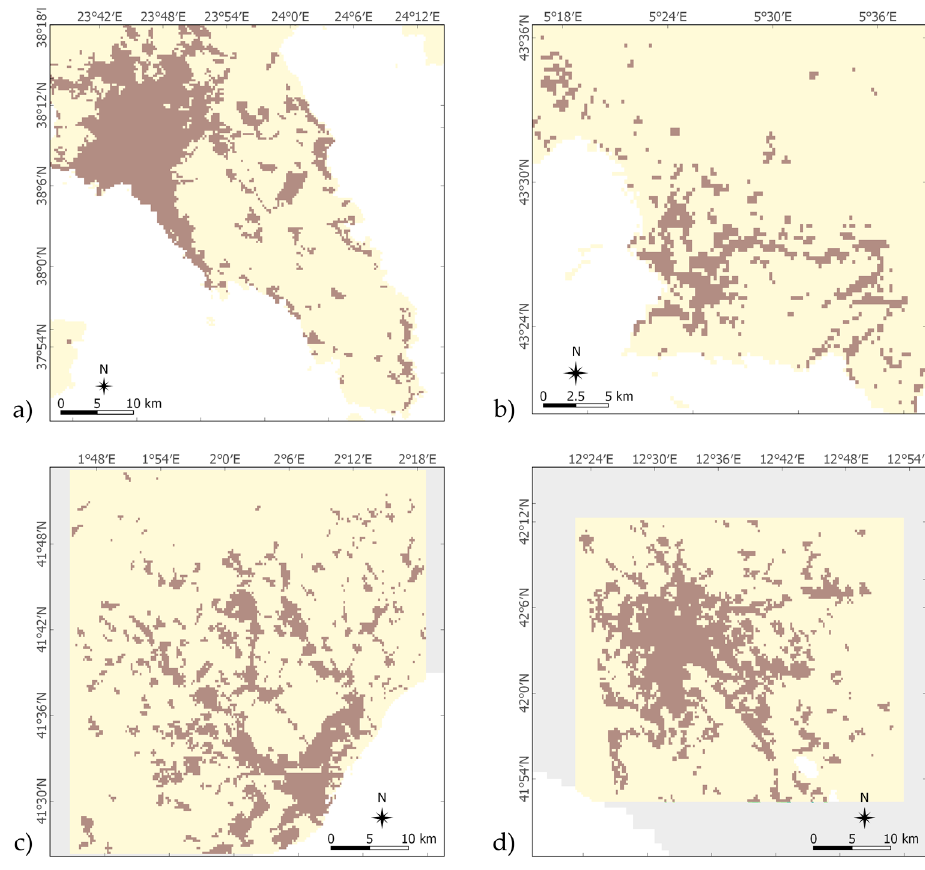
Figure 2. Figure 2. Cont.